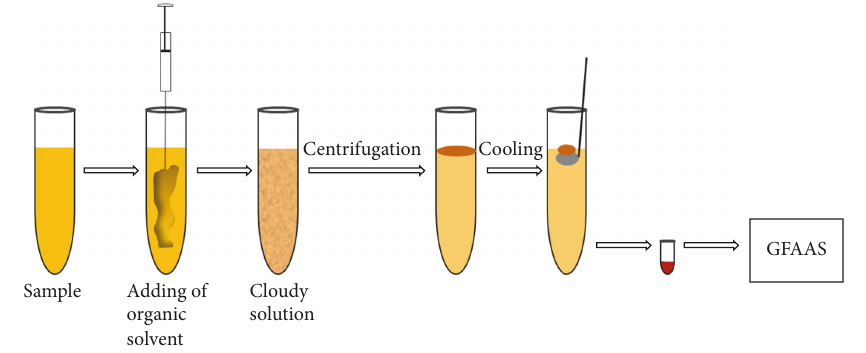
Figure 1: Schematic diagram of DLLME-SFO method.